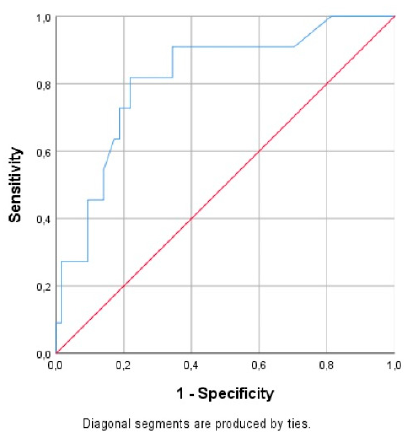
Figure 3. Area under the ROC curves of NRBCs for mortality prognosis in preterm neonates with sepsis.